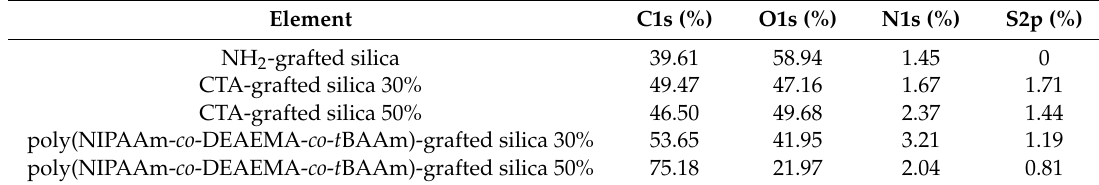
S1. The XPS results of NH 2 -grafted silica, CTA-grafted silica, and poly(NIPAAm- co - DEAEMA- co - t BAAm)-grafted 1. The XPS